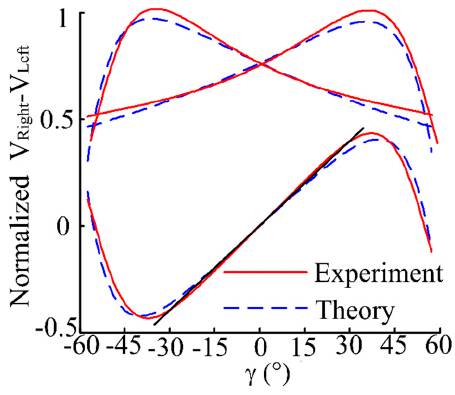
Figure 18. Angular displacement measurement experimental results of V right − V Left . ( h = 500 μ m, p = 0 μ m, α = 20°).